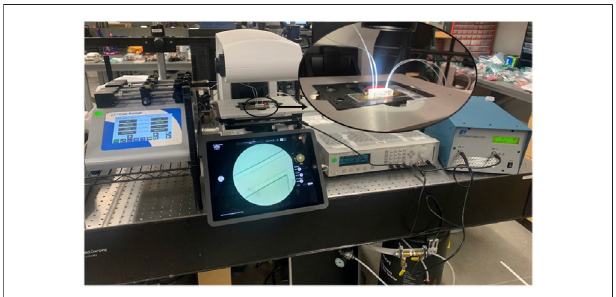
FIGURE 1 | A view of experimental setup including syringe pump, microscope, function generator, and RF ampli fi